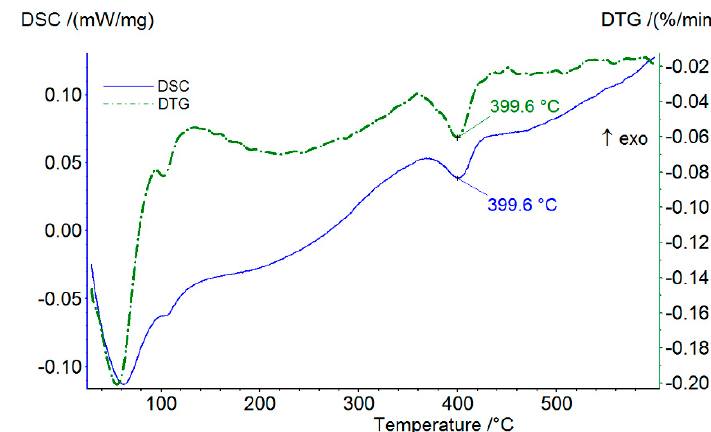
Figure 8. Thermal analysis of analcime from run Et6. Blue solid curve DSC; green dashed curve DTG.